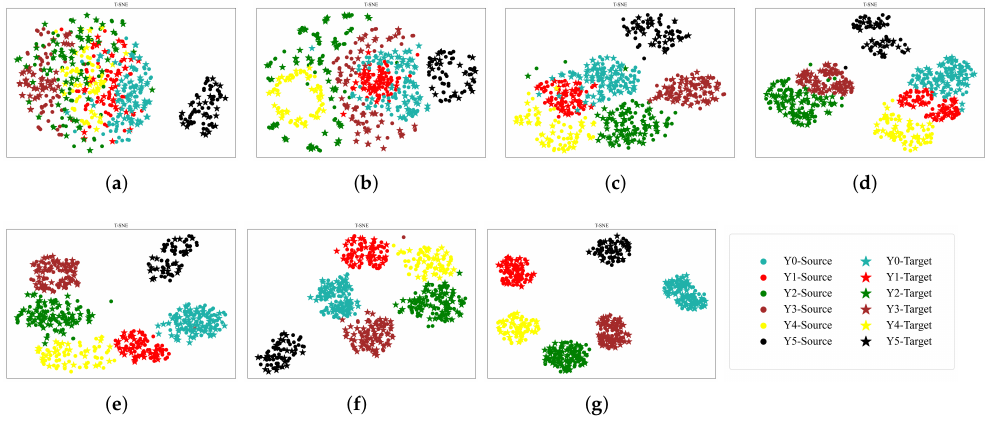
Figure 14. T-SNE feature visualization. ( a ) Source sample. ( b ) 1-D CNN. ( c ) DANN. ( d ) DATLN. ( e ) DTN. ( f ) MiDAN. ( g ) MADAN